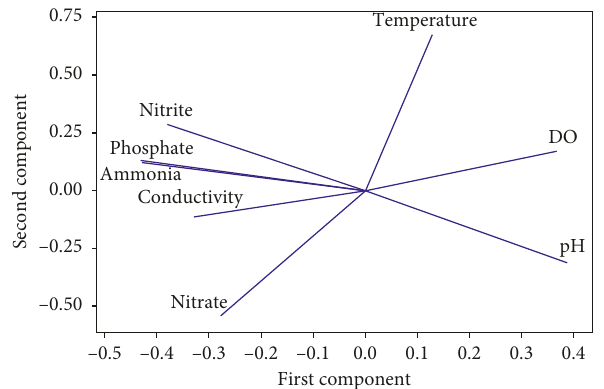
Figure 7: Component loadings for the first component and the second component for bottom